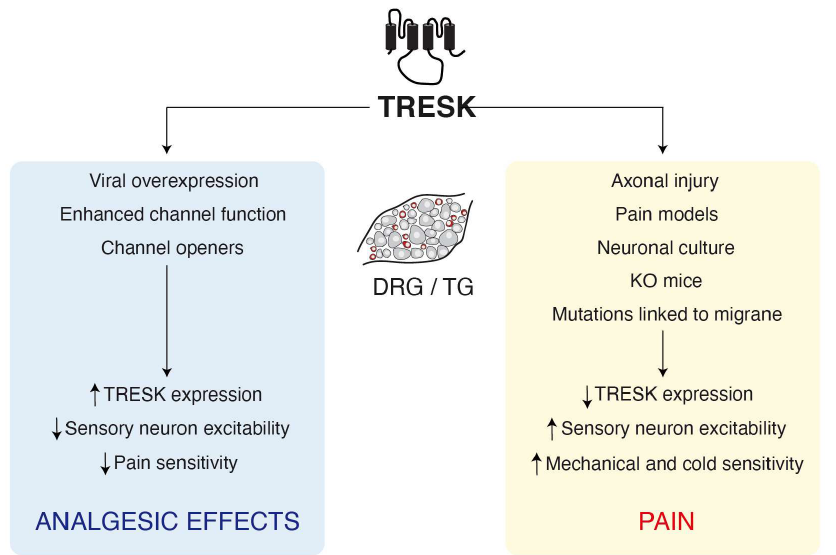
Figure 1. TRESK regulation is linked to pain or analgesic e ff ects. Axonal and neuronal injuries or TRESK mutations conduct to a decrease in channel function that leads to an increase in pain sensitivity. Enhancement of TRESK expression or channel openers decreases the excitability of sensory neurons producing analgesic e ff